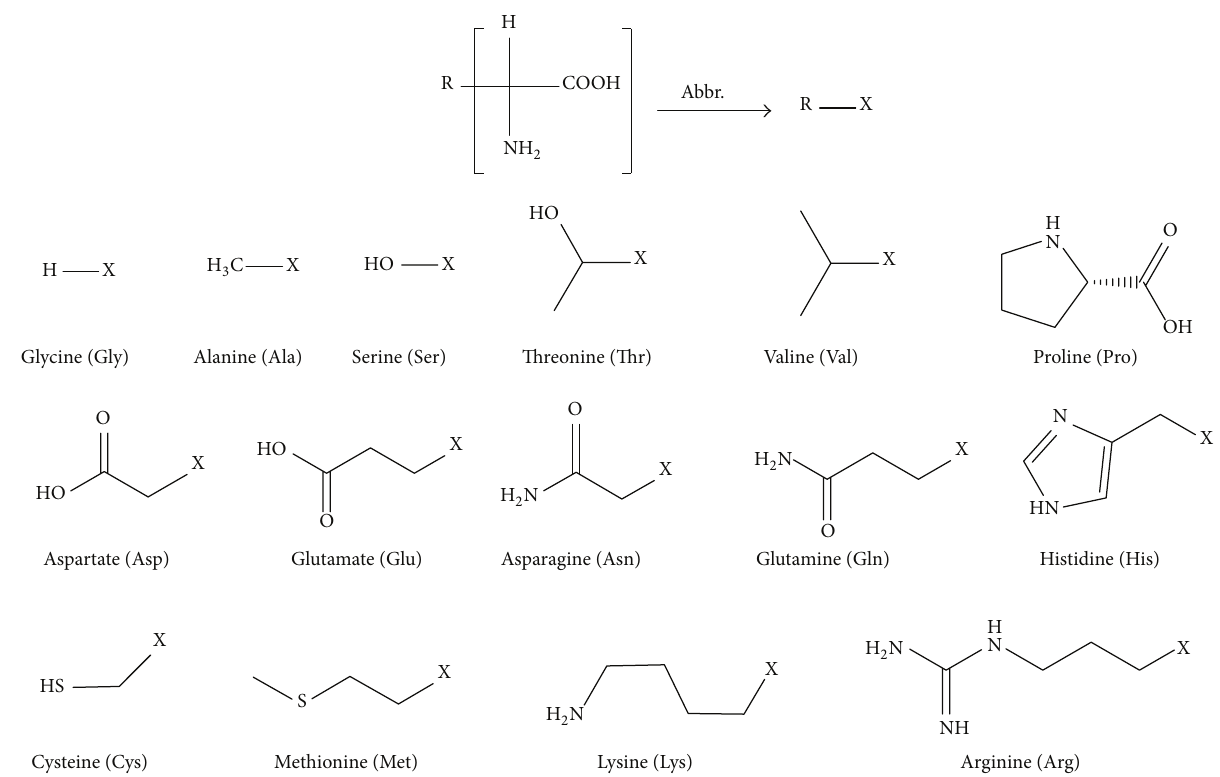
Scheme 1: Structures of 15 natural amino